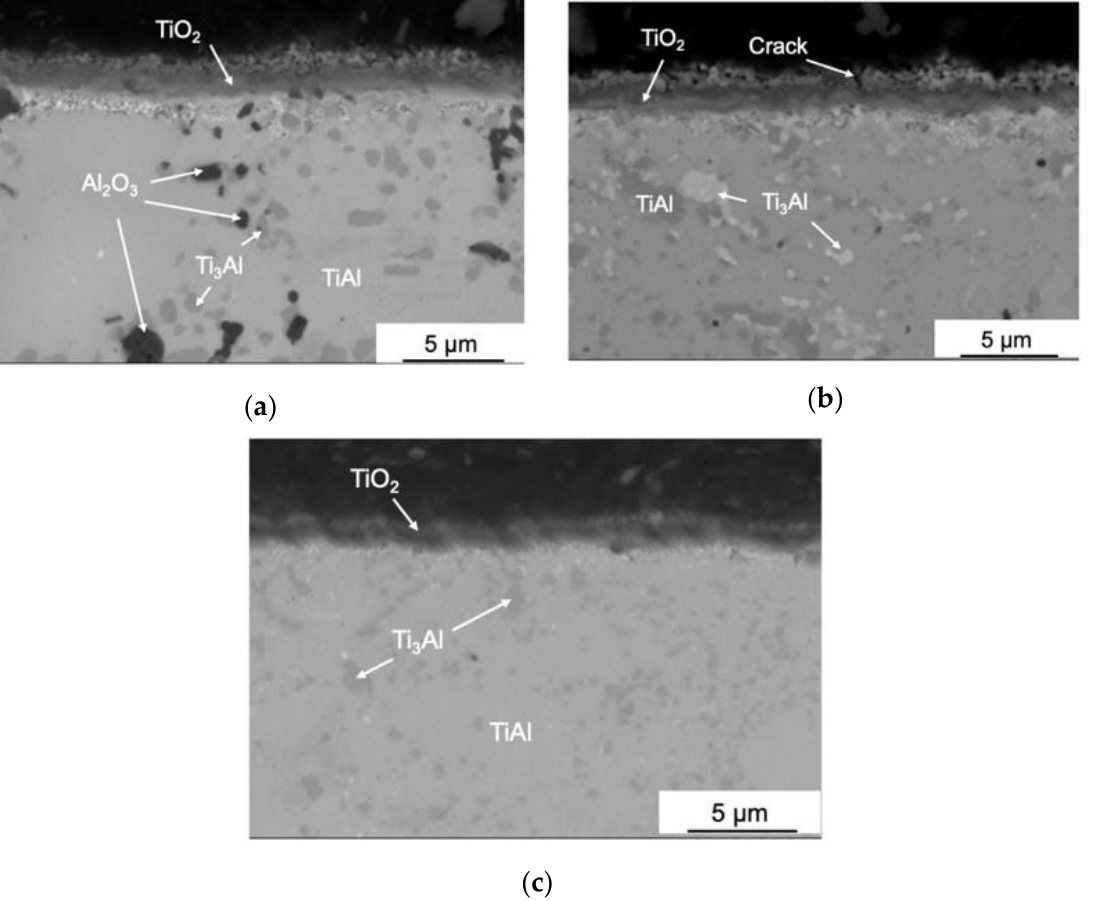
Figure 6. A cross-sectional oxidized layer image of the alloys 0.2C ( a ), 1.5Si ( b ), and 1.5Y 2 O 3 ( c ) after isothermal annealing at 800 °C.